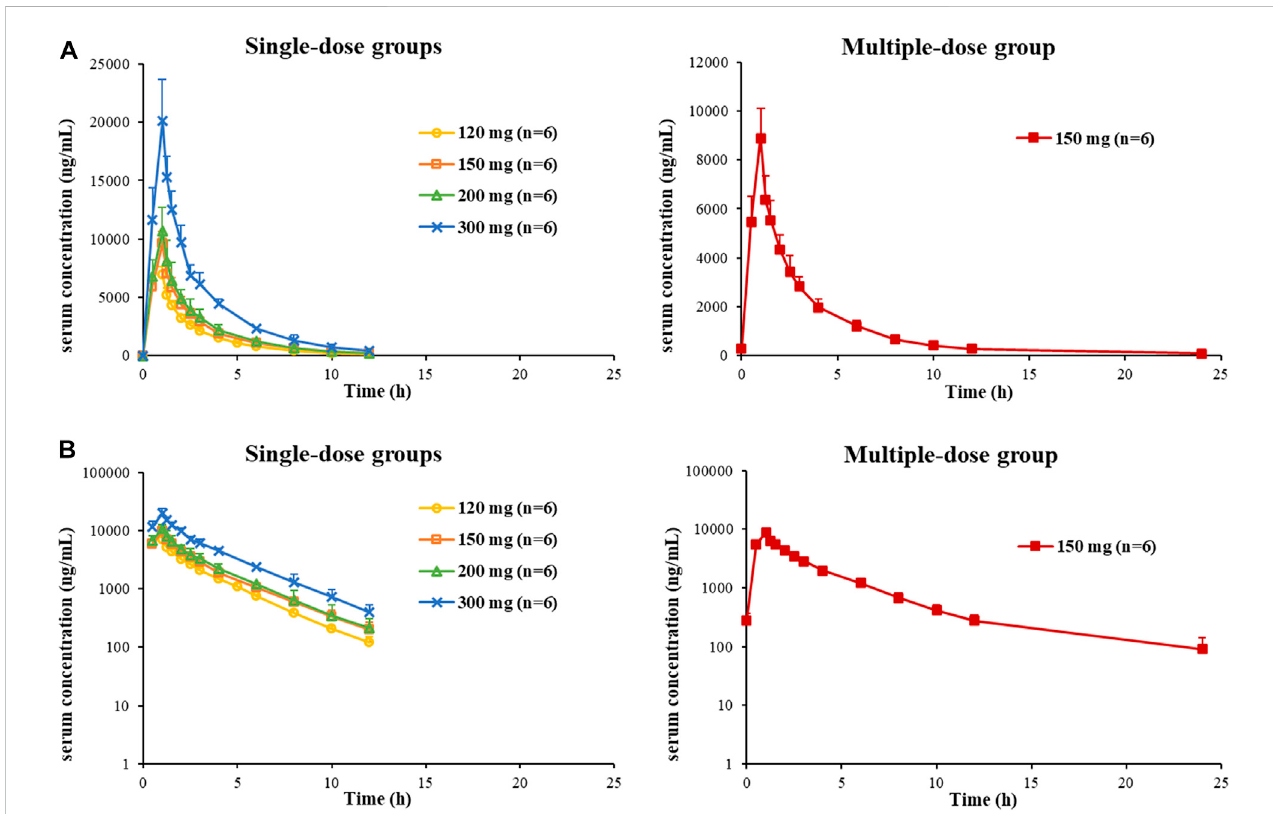
FIGURE 5 Average serum concentration – time curves of etimicin in Chinese HVs after a single dose and multiple doses, shown in Cartesian coordinates (A) and semilogarithmic coordinates (B)